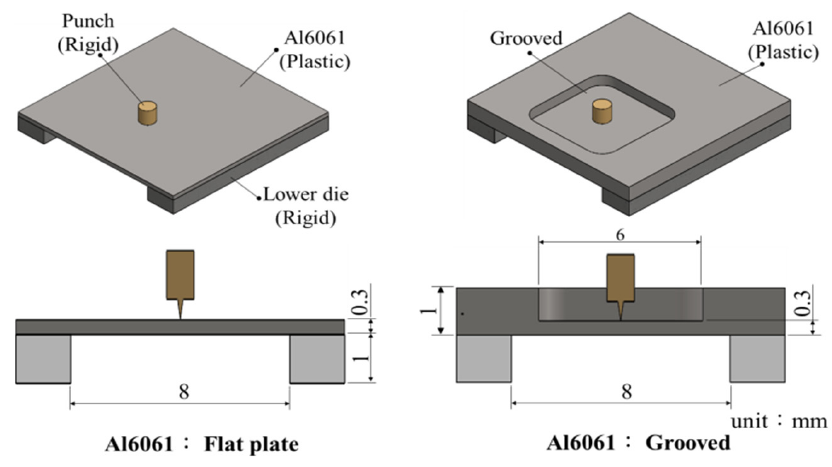
Figure 3. Stamping model specification.